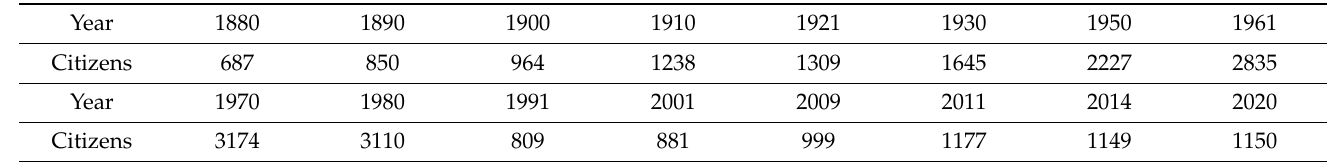
Table 2. Development of the population of the Koš